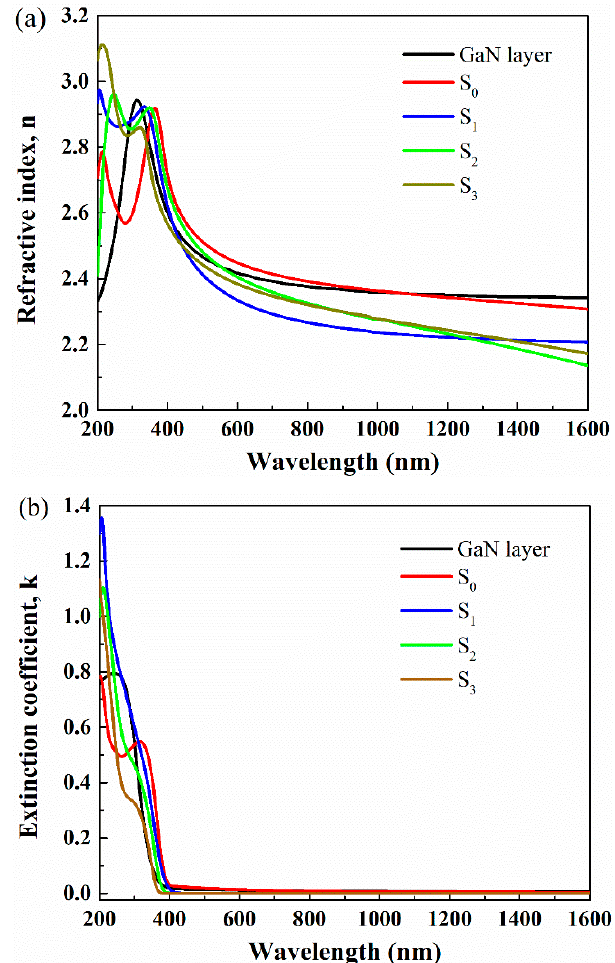
Figure 6. Fitted optical constants of Be implanted GaN samples at RT: ( a ) refractive index (n) vs. wavelength; ( b ) extinction coefficient (k) vs. wavelength.